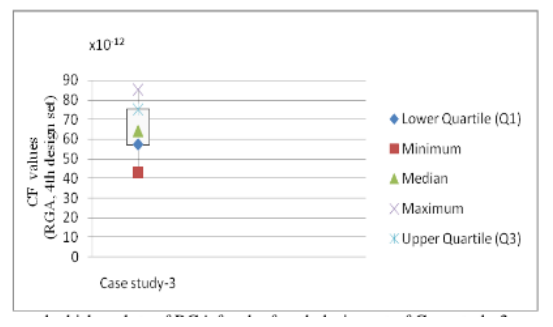
Figure 14: Box and whisker plots of RGA for the fourth design set of Case study-3 over 50 trial runs.